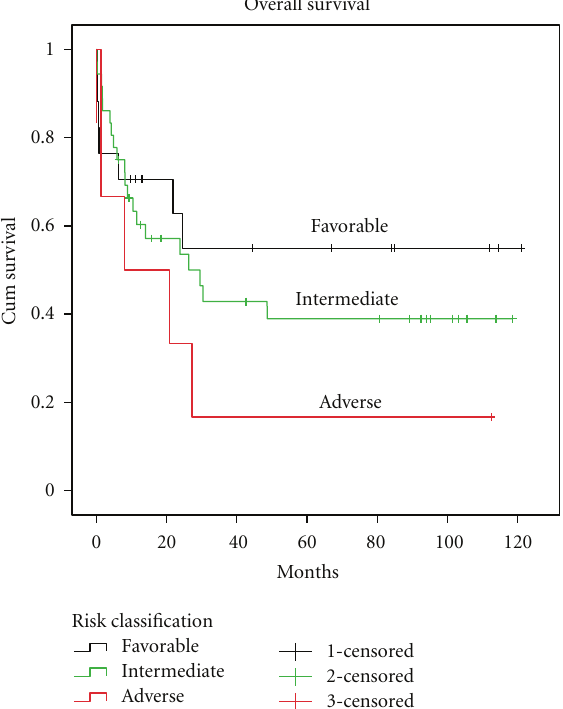
Figure 1: Comparison of the estimated overall survival according to the risk category with a followup of 120 months: favorable (54.9%), intermediate (39%), and unfavorable (16.7%) ( P = 0 .